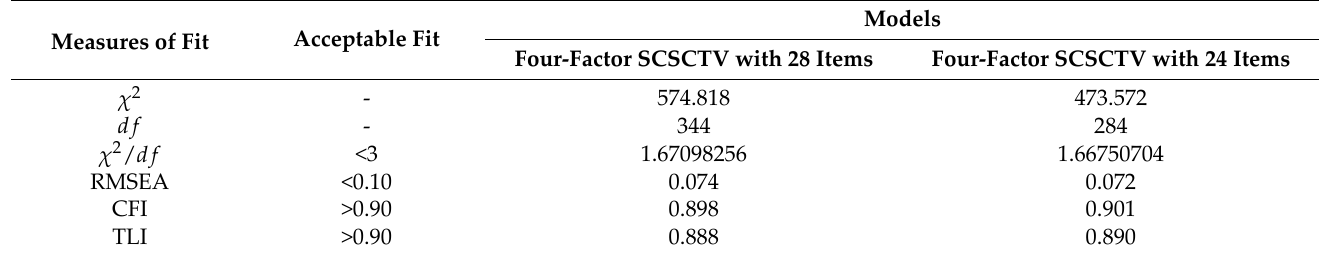
Table 5. Fit statistics for SCSCTV confirmatory factor analysis.